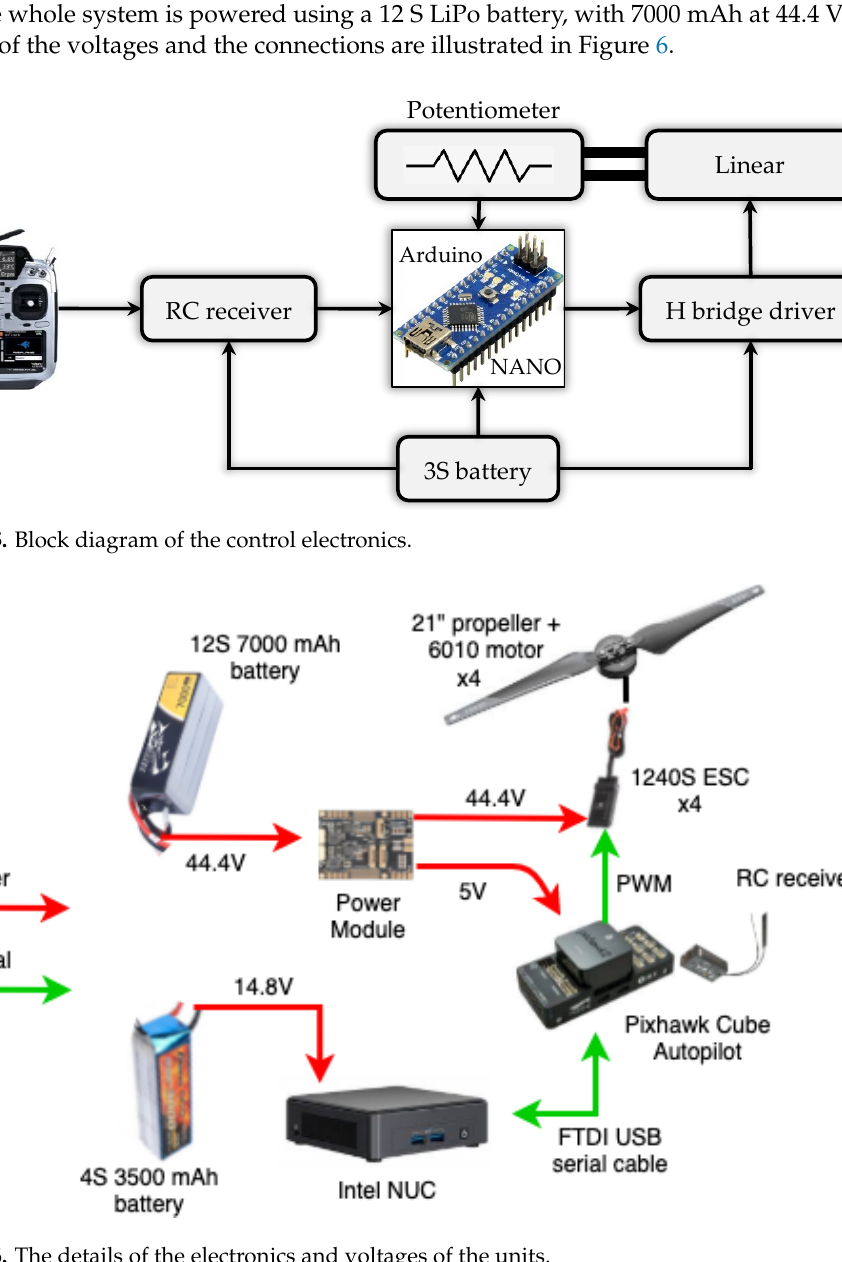
Figure 4. Detailed view of the attachment of the clamps to the linear actuator.